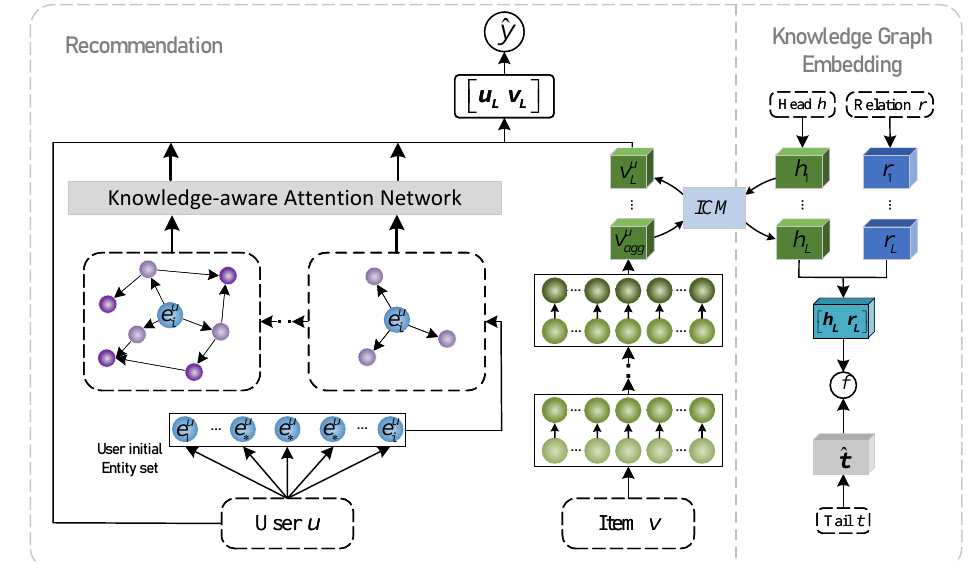
Figure 2. Illustration of the proposed KCNR model, which consists of a recommendation module, knowledge graph embedding module, and information complementary